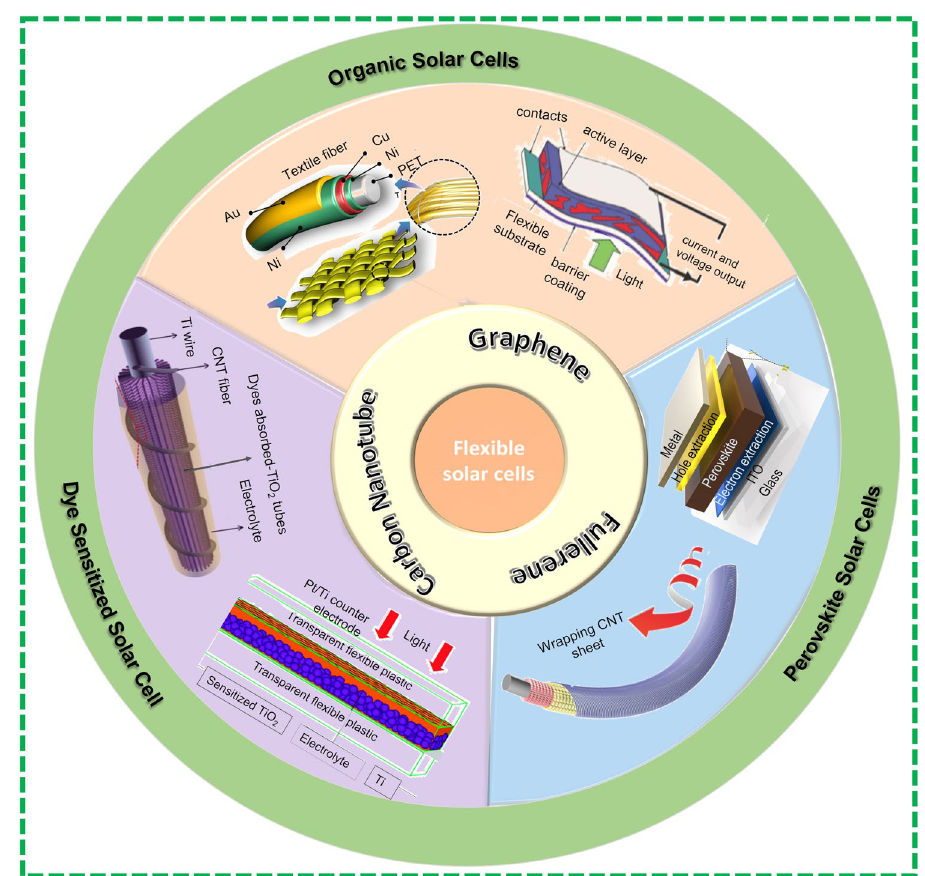
Fig. 4 Schematic view of solar energy harvesters. Reprinted with permission from Refs. [27,